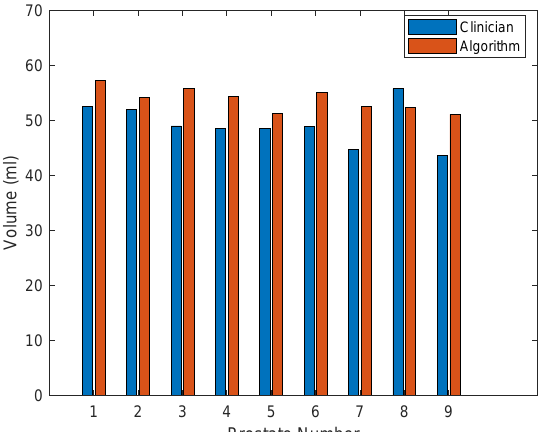
Figure 13. Average width and height of the algorithmic and clinician segmented prostate contours, measured in the U x and U y axes, respectively.